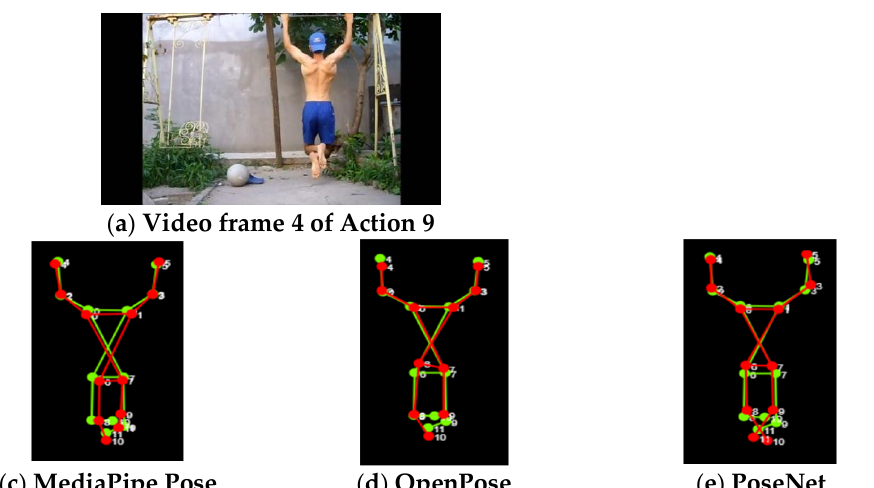
Figure 14. ( a ) Frame 4 of Action 9 (pull up). In ( b – e ), green lines indicates the ground truth while red lines indicates the tested HPE library.